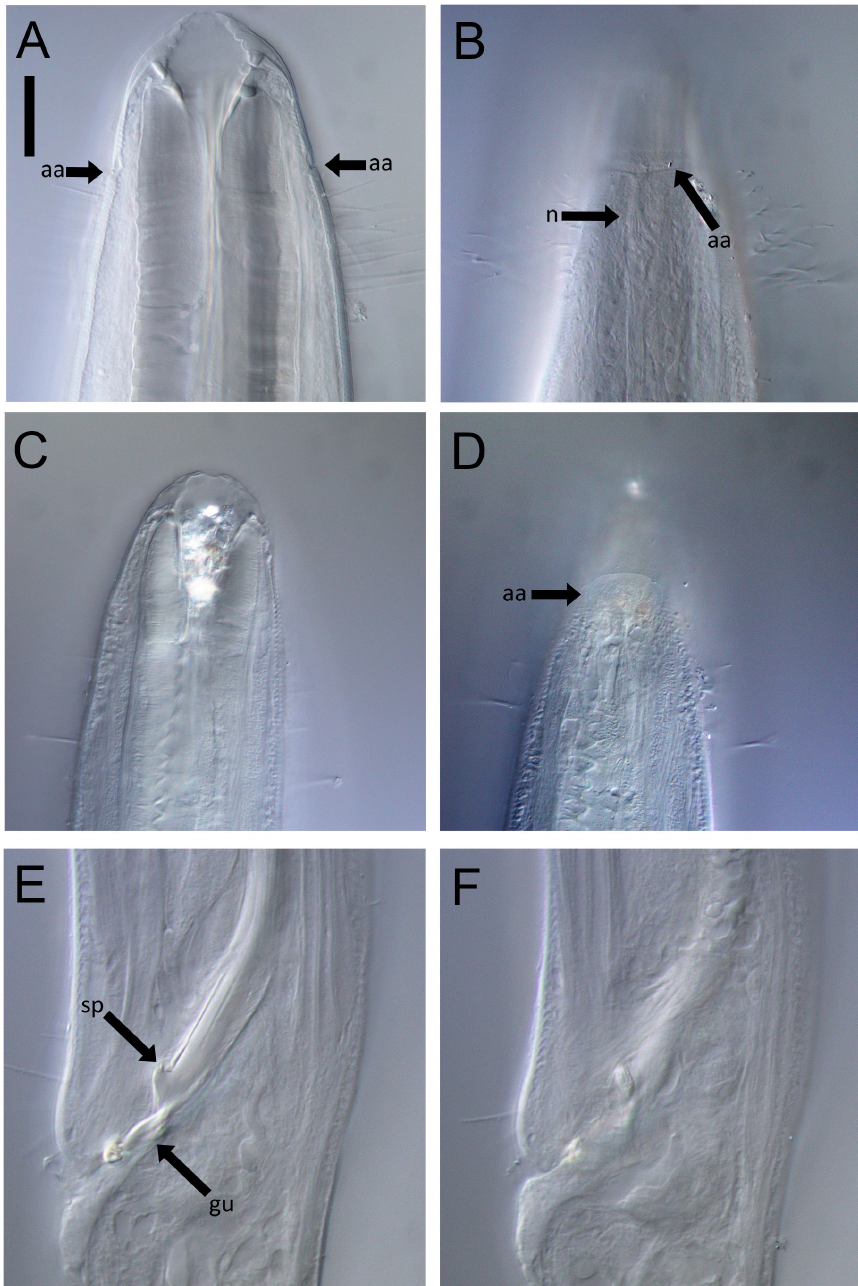
Fig. 12. Deraionema barbatum gen. et sp. nov. Light micrographs. A – B , E – F . Paratype (NIWA154915). C – D . Holotype (NIWA154917). A . Male cephalic region showing lips, buccal cavity, pharynx and subcephalic setae. B . Male cephalic region showing amphideal aperture. C . Female cephalic region showing lips, buccal cavity and pharynx. D . Female cephalic region showing amphideal aperture and subcephalic setae. E – F . Copulatory apparatus. Abbreviations: aa = amphideal aperture; gu = gubernaculum; n = amphideal nerve; sp = spicule. Scale bar = 20